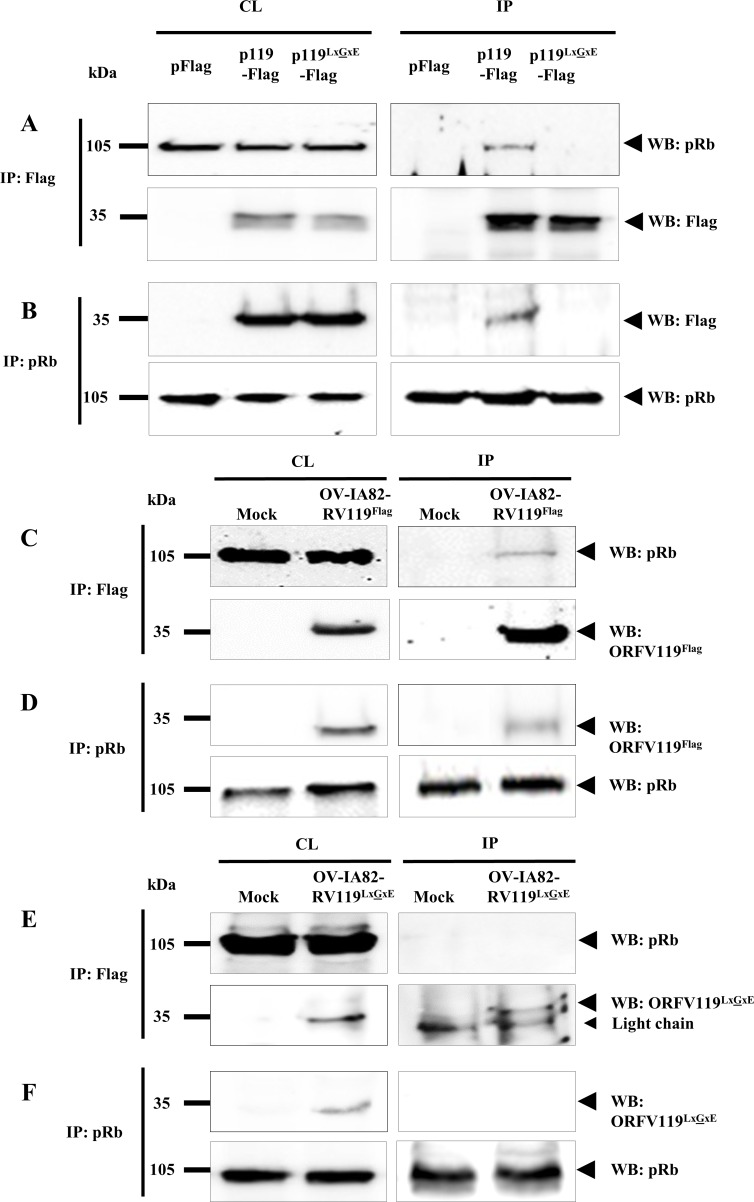
ORFV119 interacts with pRb.(A and B). 293T cells were transfected with plasmids pORFV119Flag (p119Flag), pORFV119LxGxE-Flag (p119LxGxE-Flag) or control plasmid (pFlag) and harvested at 12 h post transfection. Total cell lysate (CL) and protein extracts immunoprecipitated (IP) with anti-Flag (A) or anti-pRb (B) antibodies were examined by Western blot (WB) with antibodies against Flag or pRb. Results are representative of four independent experiments. (C-F) OFTu cells were mock infected or infected with OV-IA82-RV119Flag (C and D), OV-IA82-RV119LxGxE-Flag (E and F) (MOI, 10) and harvested at 12 h p.i. Total cell lysate and protein extracts immunoprecipitated with anti-Flag (C and E) or anti-pRb (D and F) antibodies were examined by Western blot with antibodies against Flag or pRb. Results are representative of three independent experiments. Percentage of (A) pRb co-immunoprecipitated by ORFV119Flag: 16.7±1.2%; (B) ORFV119Flag co-immunoprecipitaed by pRb: 28.4±2.3%; (C) pRb co-immunoprecipitated by ORFV119Flag in OV-IA82-RV119Flag infected cells: 8.7±1.4%; (D) ORFV119Flag co-immunoprecipitated by pRb in OV-IA82-RV119Flag infected cells: 18.5±1.91%.